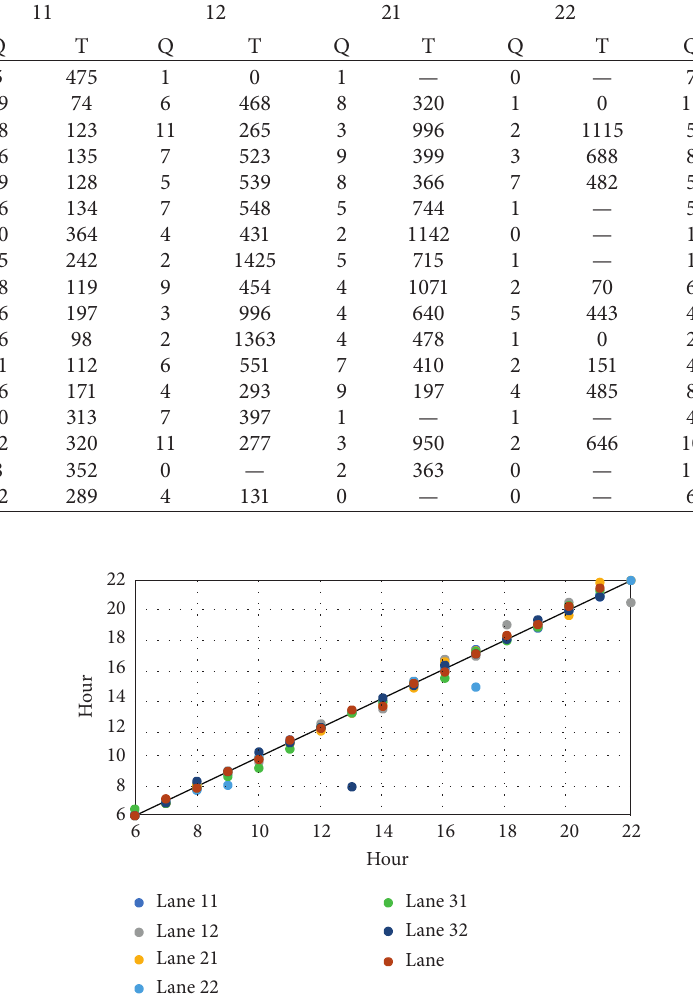
Figure 5: Average time headway of upstream and